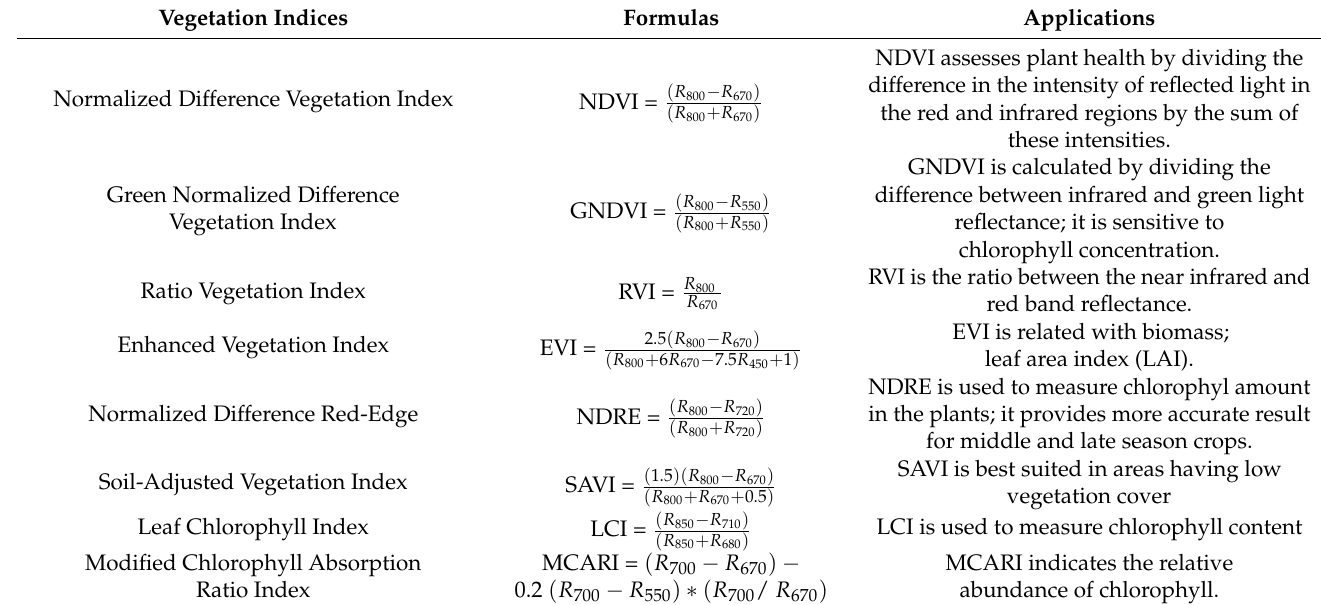
Table 1. List of commonly used vegetation indices related to plant health